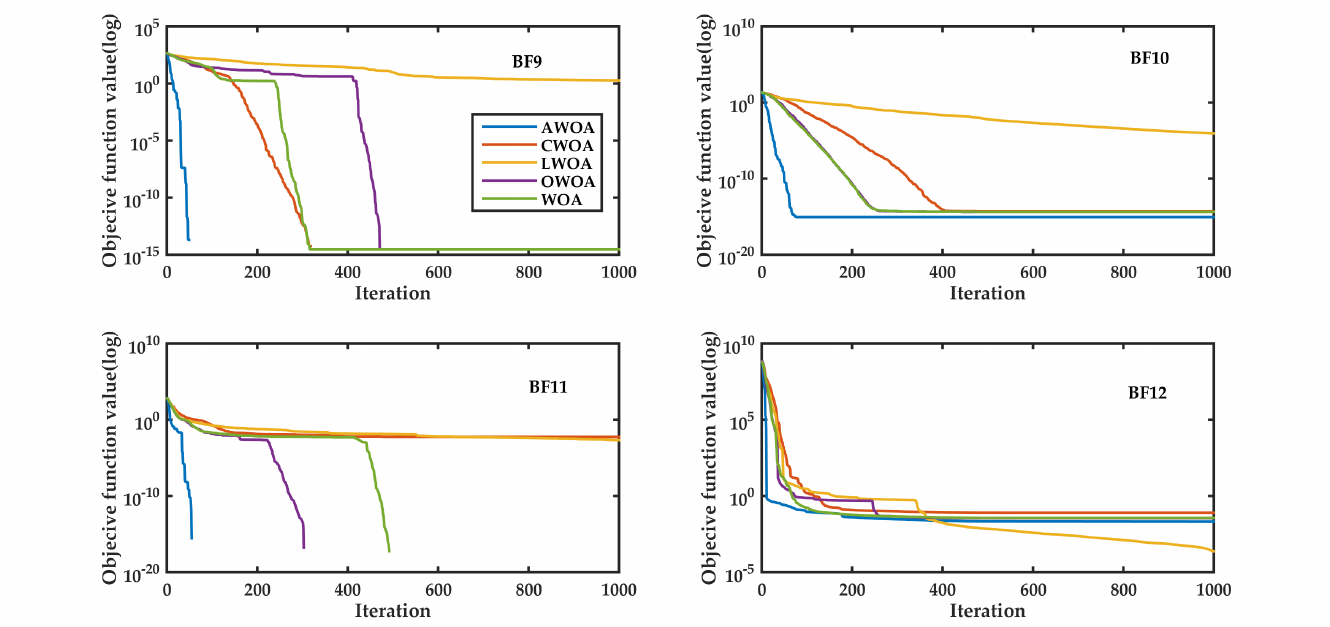
Figure 6. Convergence property analysis of multimodal